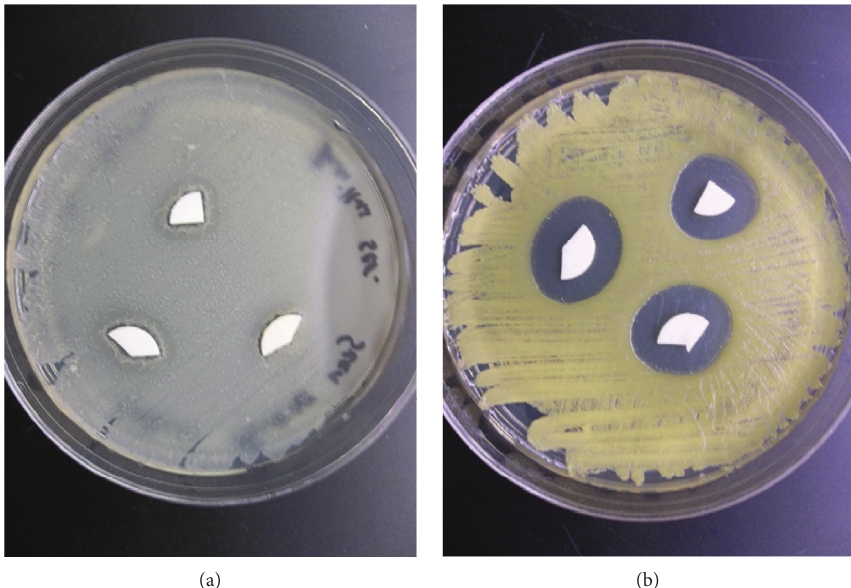
Figure 5: Kirby–Bauer disk diffusion assay. (a) Bacillus cereus. (b) Micrococcus luteus . Both bacteria were grown on LB agar. Disks were treated with a 25 mg/ml phosvitin solution containing 1mM ZnCl 2 .